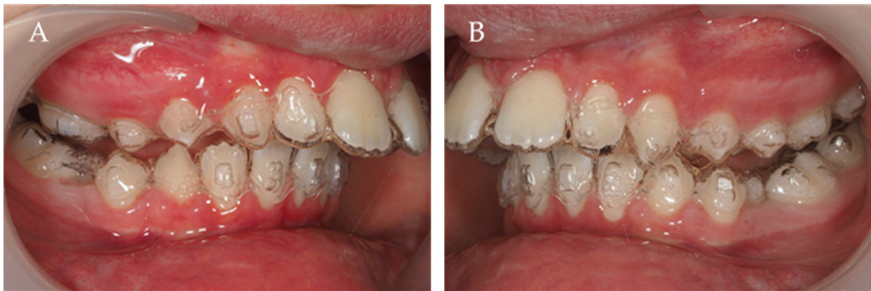
Figure 3. Intra-oral lateral right ( A ) and left ( B ) photos with the first set of aligners.